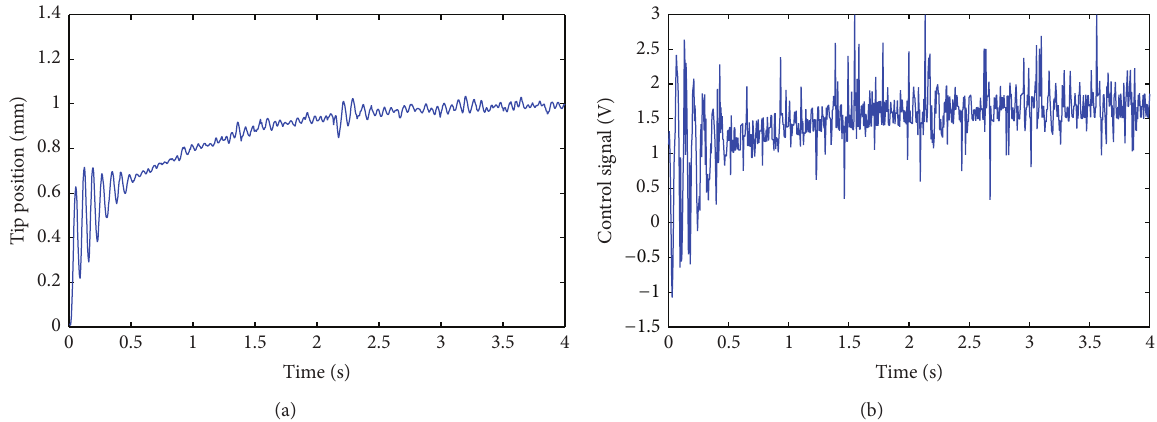
Figure 9: Step response of the closed-loop experimental system using the integer-order controller: (a) tip position, (b) control signal.